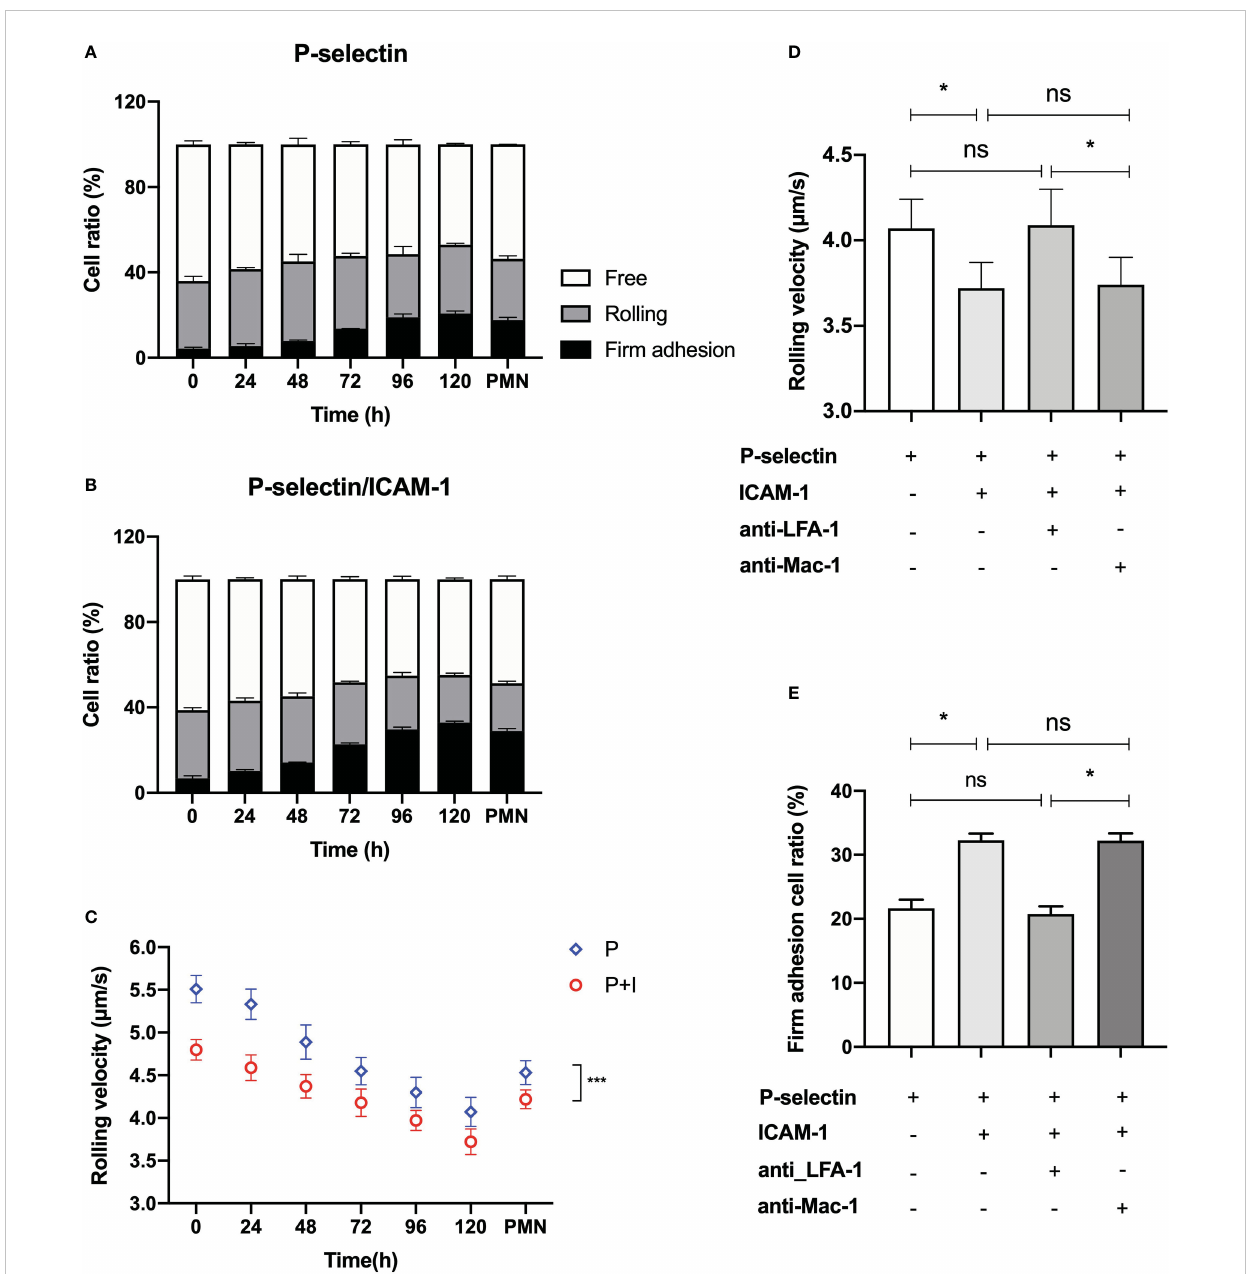
FIGURE 3 Variation of the speci fi c adhesion of all-trans retinoic acid (ATRA)-treated HL60 cells on immobilized P-selectin without or with ICAM-1 versus the stimulus time at wall shear stress of 0.3 dyne/cm 2 . Cell suspensions of neutrophils and HL60 cells with treatment of 1 × 10 -6 M ATRA for stimulus time ≤ 120 h were perfused over the parallel plate fl ow chamber substrates coated with 500 ng/ml P-selectin with or without 500 ng/ml ICAM-1 under wall shear stress of 0.3 dyne/cm 2 , the cell adhesion events in the view window were counted one by one over 5 min, and the velocity values of the rolling cells were read, too. Variation of the ratios of free, rolling, and fi rmly adhered ATRA-treated HL60 cells on P-selectin alone (A) or combined with ICAM-1 (B) versus stimulus time. (C) Plot of the rolling velocity of ATRA-treated HL60 cells on P-selectin alone or combined with ICAM-1 against stimulus time. The velocity plot against time also showed the data of rolling neutrophils for comparison. (D) Rolling velocity and (E) fi rm adhesion ratio of 120-h-ATRA-treated HL60 cells on P-selectin alone or combined with ICAM-1 using anti-CD11a and anti-CD11b antibodies to block LFA-1 or Mac-1 on the HL60 cells in the presence of ICAM-1 under wall shear stress of 0.3 dyne/cm 2 . Data are presented as mean ± SD (A, B, E) or mean ± SEM (C, D) and represented at least 100 events from three independent experiments. Statistical signi fi cance was analyzed by two-way ANOVA followed by Tukey ’ s multiple-comparisons tests (C) or by Student ’ s t -tests (D, E) . * P < 0.05, *** P < 0.001, and ns means no signi fi cant